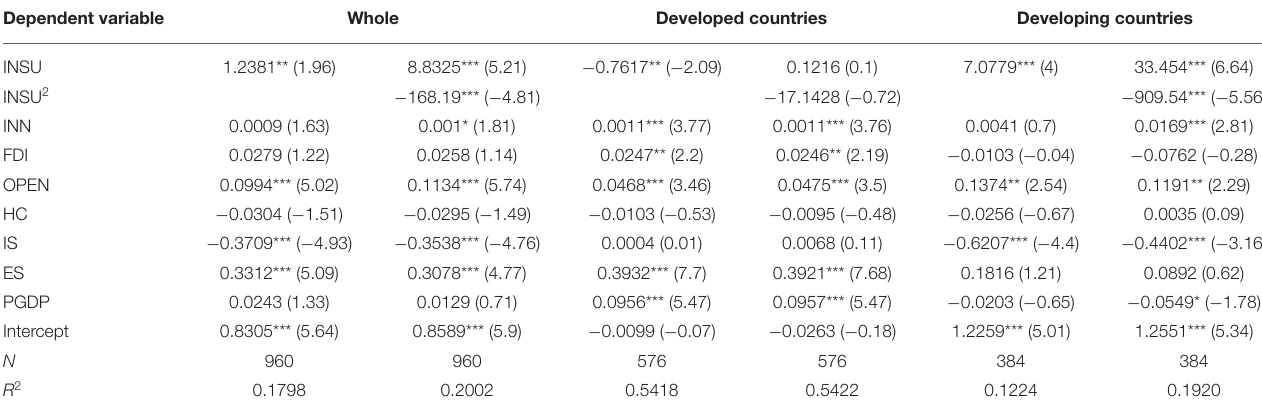
TABLE 6 | Estimation of the impact of insurance development on GTFP. Dependent